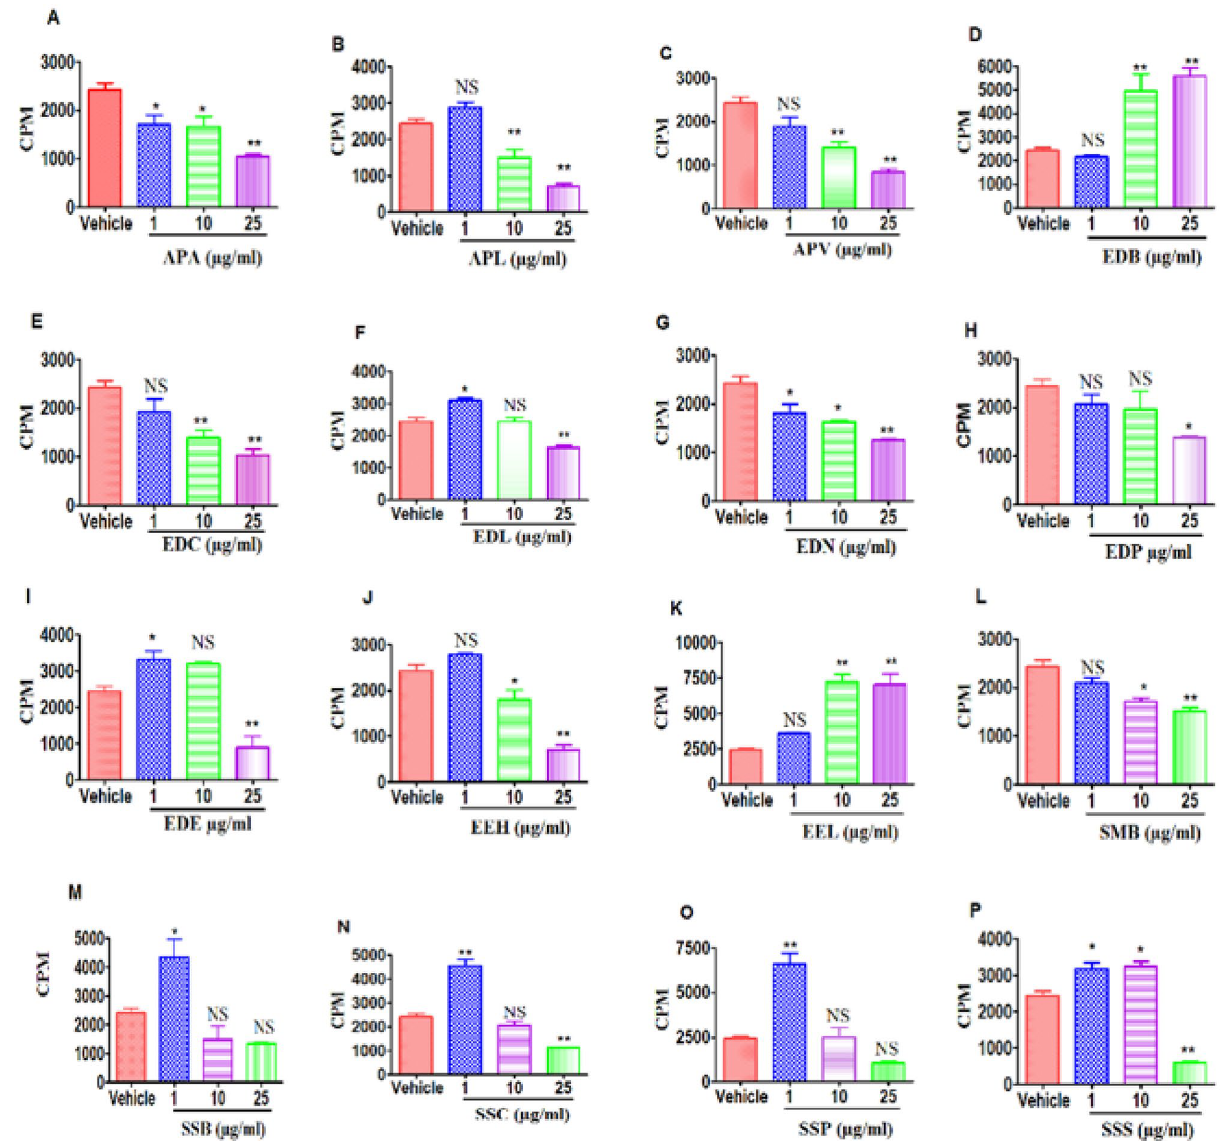
Figure 10. Effect of APL treatment on the proliferation of T cells: This was determined by 3 H-Thymidine incorporation after 24 h treatment with plant extracts or vehicle, DMSO. ( A – C ) represent the Asteraceae family (( A ) APA, ( B ) APL, ( C ) APV). ( D – I ) represent the Ebenaceae family (( D ) EDB, ( E ) EDC, ( F ) EDL, ( G ) EDN, ( H ) EDP, ( I ) EDE). ( J , K ) represent the Erythroxylaceae family (( J ) EEH, ( K ) EEL). ( L – P ) represent the Sapotaceae family (( L ) SMB, ( M ) SSB, ( N ) SSC, ( O ) SSP, ( P ) SSS). The vertical bars represent mean ± S.E.M. of triplicate cultures and data were expressed as counts per minute (CPM). The significance between various groups was tested using one-way ANOVA where NS: Not significant; (*)p < 0.05, (**)p < 0.01, (***)p <